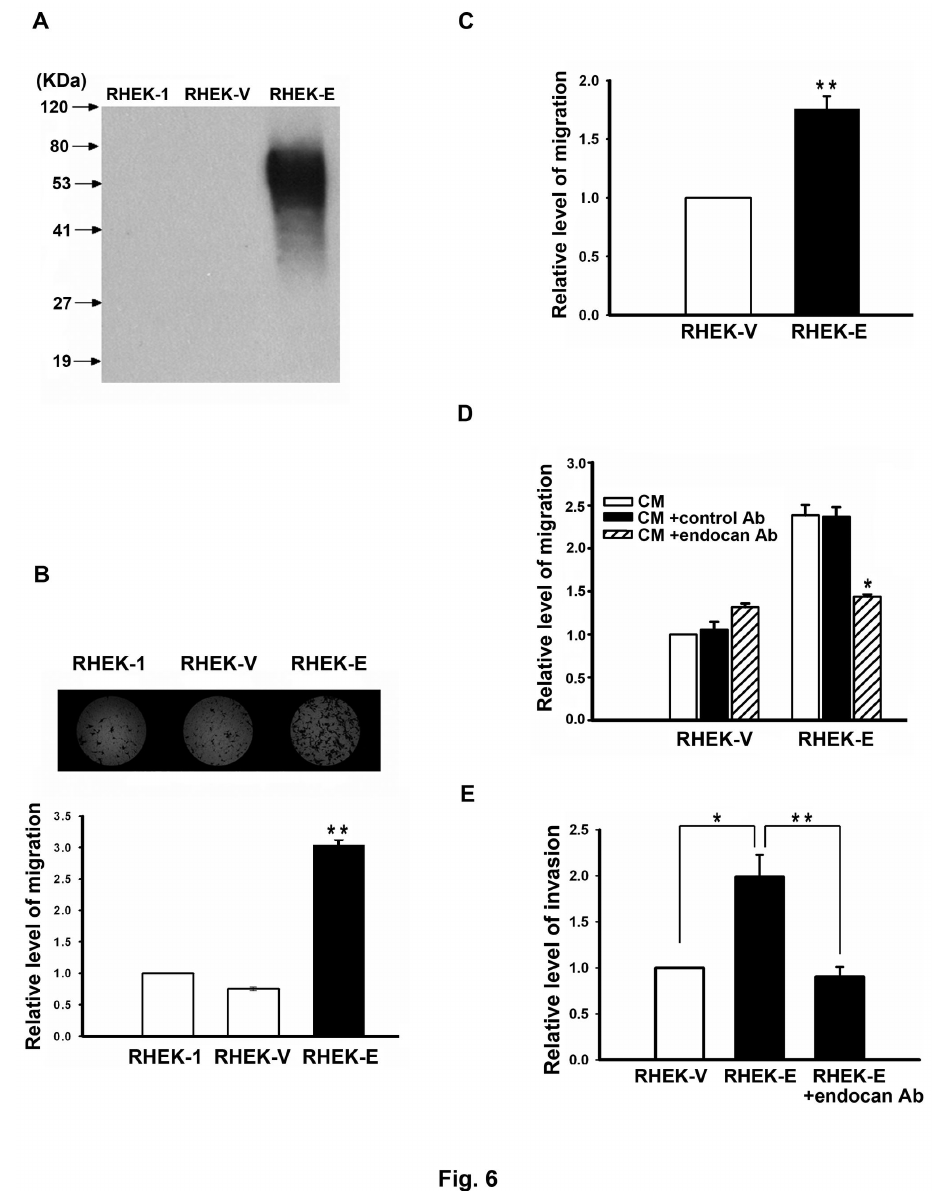
Figure 6. Endocan stimulates the migration and invasion ability of endothelial cells. ( A ) Western blot analysis shows the amount of endocan in the concentrated CM of RHEK-1, RHEK-Vec, and RHEK-endocan cells. ( B ) Effect of the CM from RHEK-1, RHEK-Vec, and RHEK-endocan cells on HMEC-1 cell migration. Upper panel, images of migrated HMEC-1 endothelial cells in the presence of CM from RHEK-1, RHEK-Vec, and RHEK-endocan cells. Lower panel, quantitation of migrated HMEC-1 endothelial cells. The migrated cells were counted in six randomly selected microscopic fields (x 200 magnification). Values represent means ± SD. ** P < 0.005 versus CM from RHEK-Vec cells. ( C ) Effect of the CM from RHEK-Vec and RHEK-endocan cells on HUVEC cell migration. The migrated cells were counted in six randomly selected microscopic fields. Values represent means ± SD. ** P < 0.005 versus CM from RHEK-Vec cells. ( D ) Pretreatment of CM from RHEK-endocan cells with anti-endocan antibody reduces its ability to induce HMEC-1 cell migration. CM from RHEK-Vec or RHEK-endocan cells was pre-treated with 200 ng/mL control or anti-endocan monoclonal antibody (Abnova) before using them for transmigration assays. The migrated cells were counted in six randomly selected microscopic fields. Values represent means ± SD. * P < 0.05 versus control antibody-pretreated CM. ( E ) Effect of endocan on the invasion ability of HMEC-1 endothelial cells. The cells that invaded and migrated to the lower chamber were counted in six randomly selected microscopic fields. Values represent means ± SD. * P < 0.05, ** P < 0.005. RHEK-V, RHEK-Vec cells; RHEK-E, RHEK-endocan cells. doi: 10.1371/journal.pone.0082254.g006 PLOS ONE |